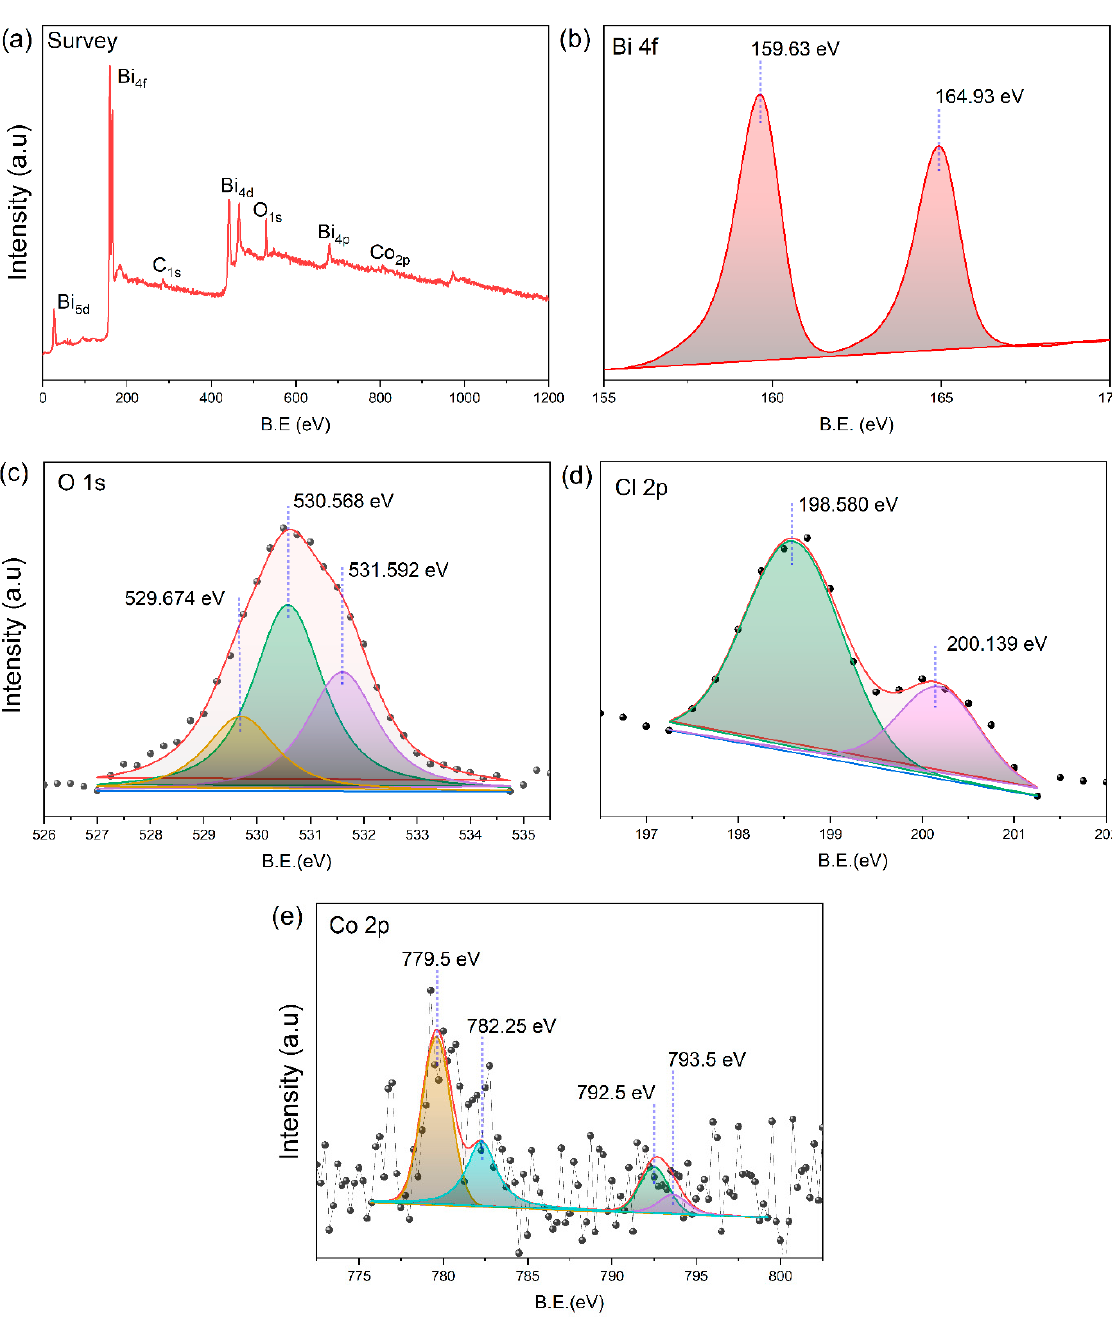
Figure A3. XPS survey spectra ( a ), core level spectra of ( b ) Bi 4f, ( c ) O 1s, ( d ) Cl 2p, and ( e ) Co 2p spectra for the prepared 20-Co 3 O 4 /BOC samples.